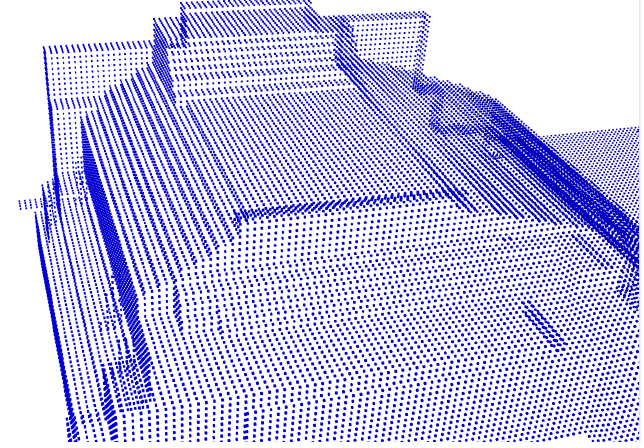
Figure 1. Simplified 3D geometric model of the shelter object, which houses the Unit 4 reactor.